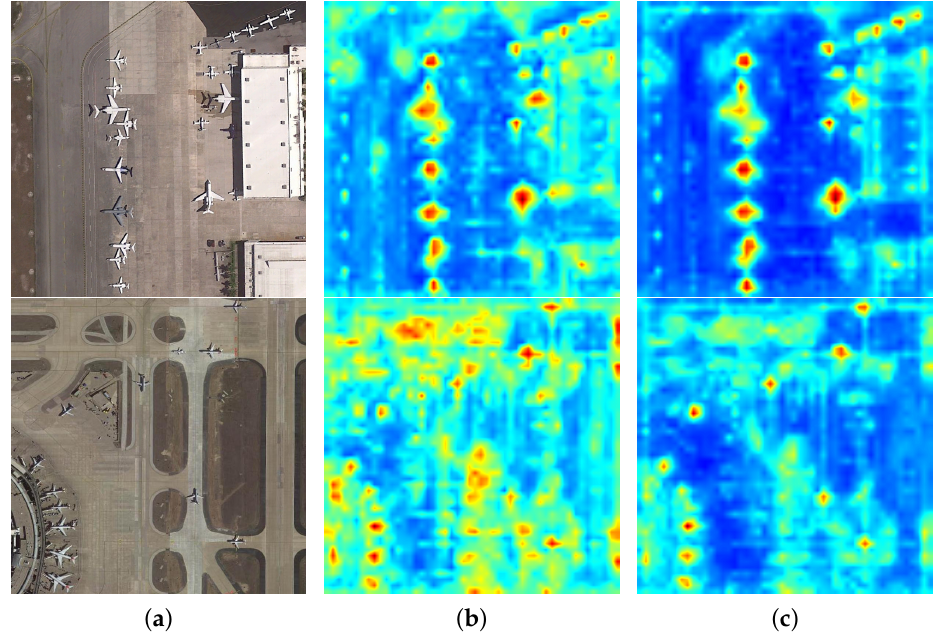
Figure 6. Examples of heatmap visualisations on the DIOR dataset. ( a ) Input image, ( b ) heat map of original model, ( c ) heat map of student